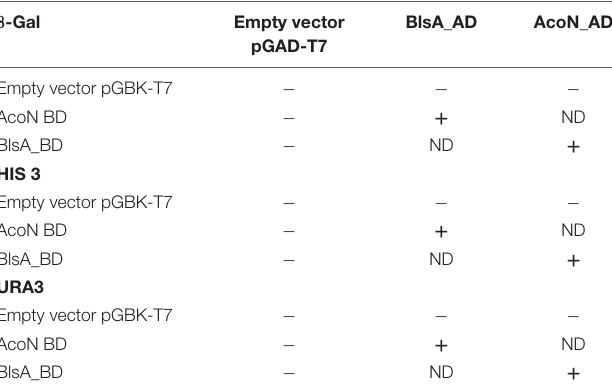
TABLE 5 | The interaction between AcoN and BlsA was determined by the yeast two hybrid assay, using GAL4 activation domain (AD) and DNA-binding domain (BD) fusion proteins.